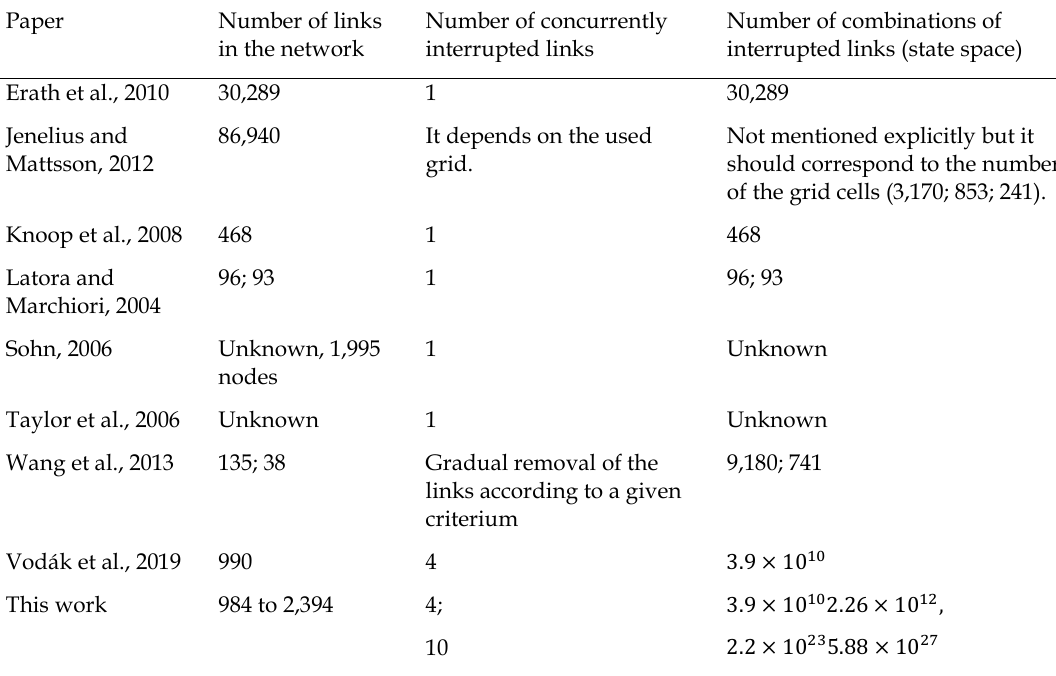
Table 6. Road networks, number of interrupted links and state space used in the previously published